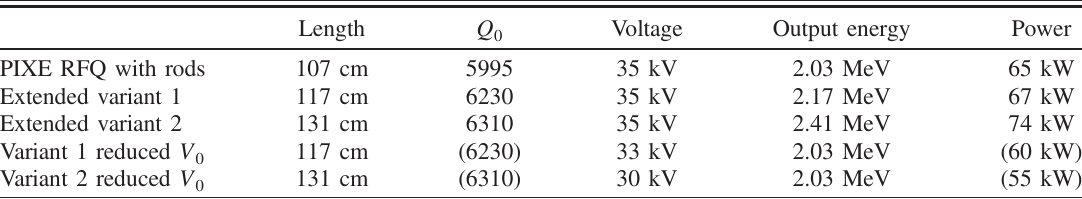
TABLE IV. Estimation of extended RFQ power